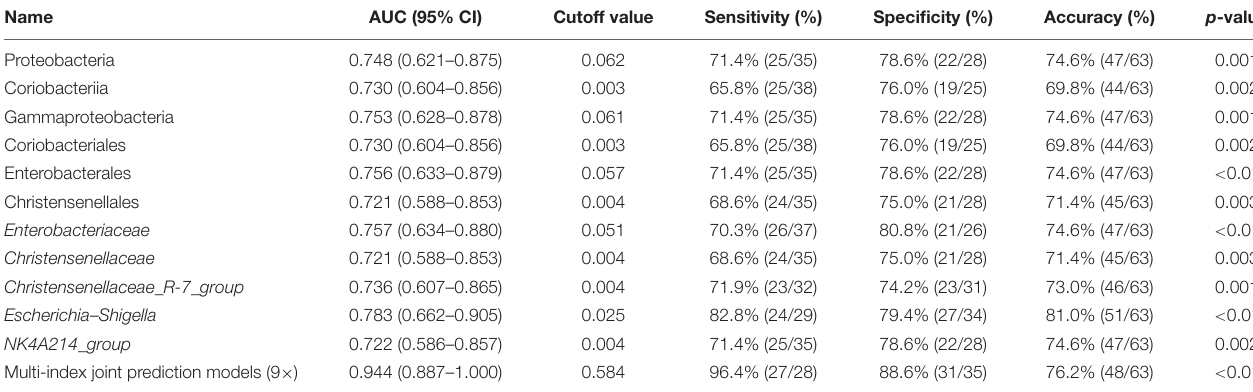
TABLE 4 | Index prediction models and efficacy evaluation for the risk of mild cognitive impairment in hypertension patients.